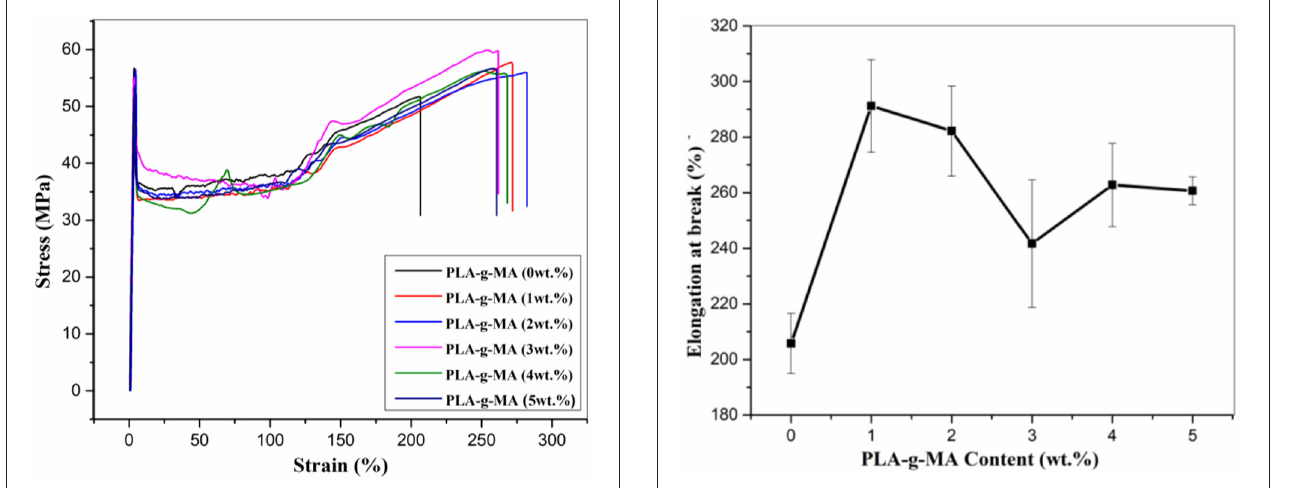
FIGURE 2 | Ductility of PLA/PA12 blends with varying PLA-g-MA content.